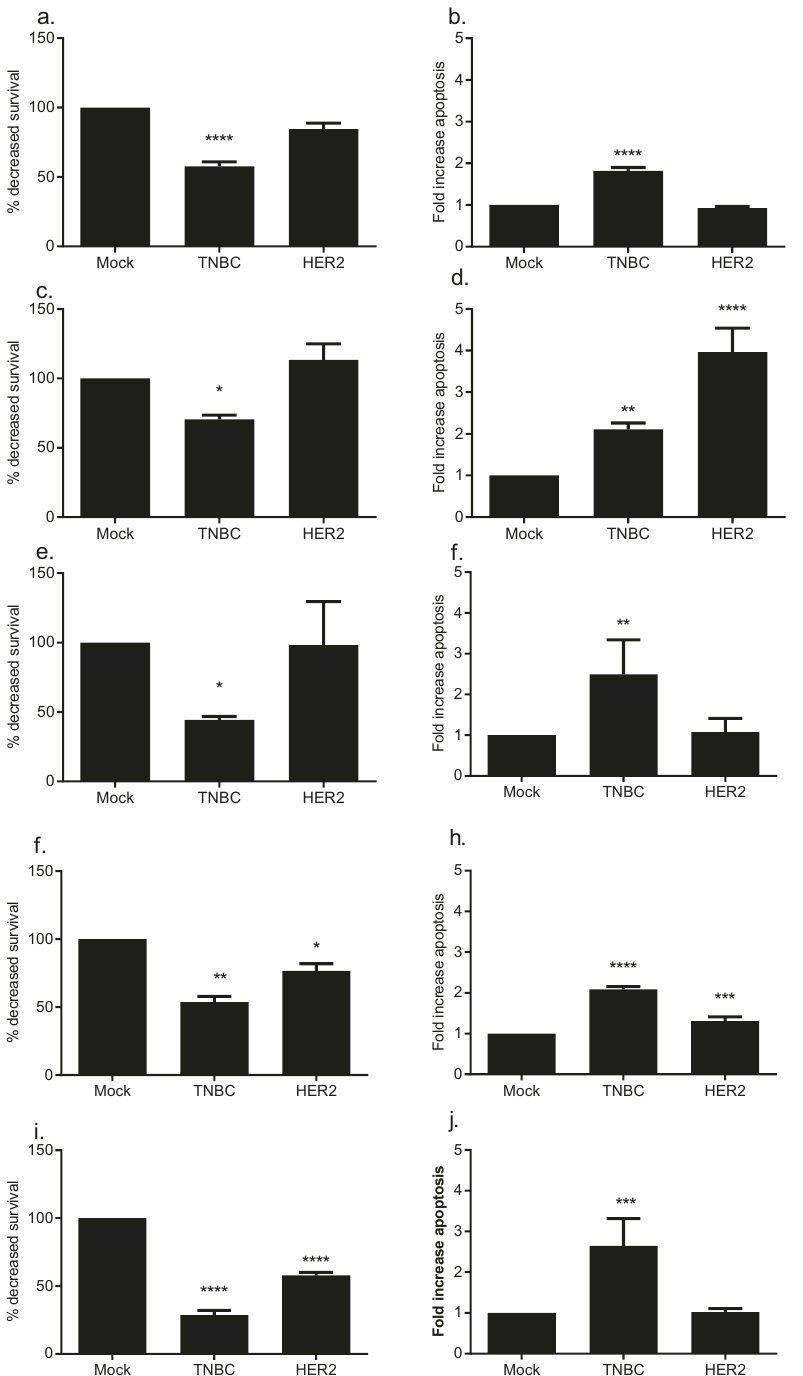
Fig. 2 siRNA knockdown of candidate antigen expression decreases cell survival and increases apoptosis in human breast cancer cell lines. Four pooled siRNA knocked down expression of the targets VPS35 ( a , b ), ARPC2 ( c , d ), SERBP1 ( e , f ), KRT8 ( g , h ), and Pdia6 ( i , j ). Decreased expression of these proteins demonstrate decreased survival ( a , c , e , g , and i ) and increased apoptosis ( b , d , f , h , and j ) as compared to mock transfected in either triple negative (TNBC, HCC70) or HER2 positive (HER2, SKBR3) human breast cancer cell lines. Survival is measured as % survival compared to mock transfected cells and apoptosis is measured as fold increase compared to mock transfected calls. All studies are in triplicate. Error bars are standard error of mean (SEM) **** p < 0.0001, *** p < 0.001, ** p < 0.01, * p < control women, Fig. 5d), and PDIA6 ( p = 0.003 compared to Only a minority of the DCIS and IBC patients had known hormone control women, Fig. 5e). When evaluating all fi ve autoantibodies, and/or HER2 receptor status (Table 2). In women with fi broade- they could distinguish women with fi broadenoma from controls noma, an autoantibody response occurred against VPS35 ( p = with AUC 0.95 (95% CI 0.90 – 1.0, p < 0.0001) but not signi fi cantly 0.007 compared to control women, Fig. 5a), SERBP1 ( p < 0.0001 from women with benign breast disease (Table 3). In women with compared to control women, Fig. 5c), KRT8 ( p = 0.03 compared to